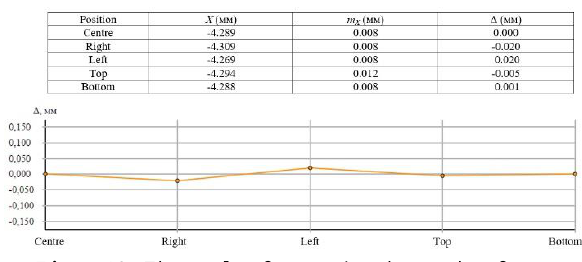
Figure 10. The results of processing photos taken from a distance of 1 m and f = 55 mm without the distortion correction. The results of photos processing shown in Fig.10 have an amplitude of X values equal to 0.040 mm. The average value of X counts is -4.290 mm and the RMS deviation is 0.013 mm.